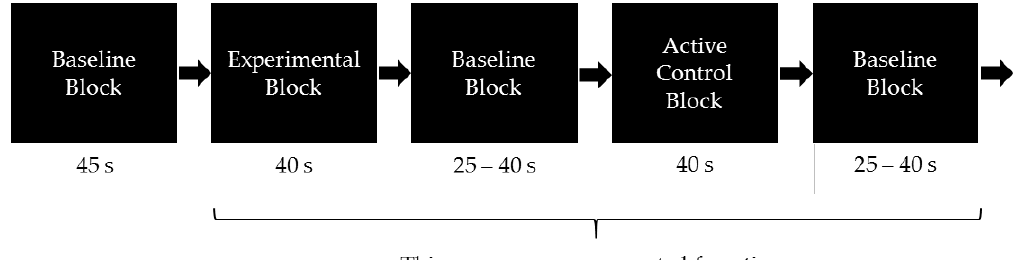
Figure 1. Illustration of the block design, which contained eight baseline blocks (resting phases), four experimental blocks, and four active control blocks. After the first baseline block, participants started either with an experimental or an active control block (order was counterbalanced across participants).